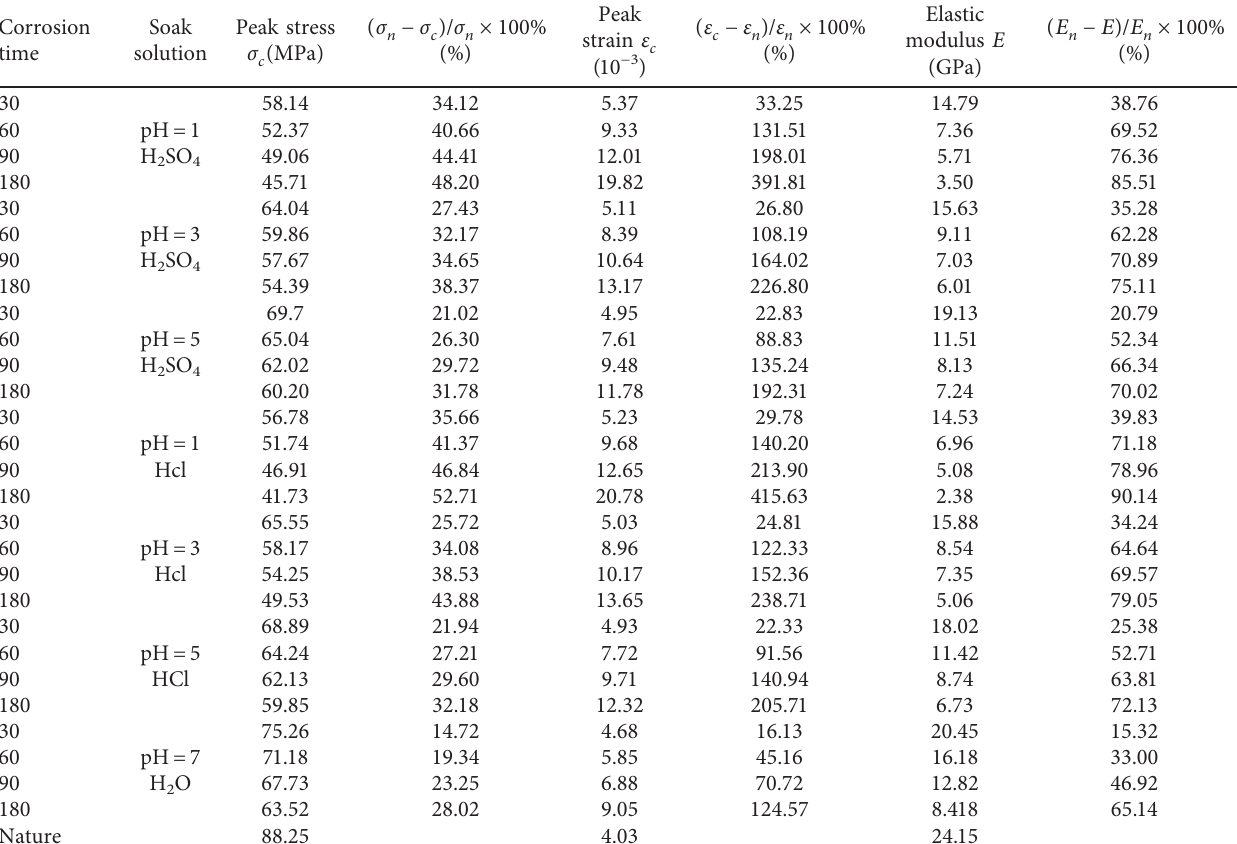
Table 3: Uniaxial compressive test results of sandstone samples subjected to acid